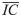
Competition localization increases with growth rate or the distances between colonies, and decreases with the resource diffusion constant.A) Two simulation “maps” with the same founder cell geometry but different growth rates. Circle size is proportional to final biomass of colonies begun with a single founder cell in a spatial environment after resources have been exhausted. The lines designate the Voronoi polygons. The text above each simulation diagram shows ζ on top. On the bottom we show the growth rate (μ1) back-calculated from the scaled model’s ζ when the resource diffusion constant is similar to that of glucose in agar and the simulation area is 2.5cm X 2.5cm. B) A plot of relative biomass (biomass of a focal colony divided by the summed biomass of all colonies) versus relative polygon area (polygon area of a focal colony divided by the total simulation area) for the two simulations shown in A. Each point represents a different colony. The lines are linear least-squares fits, and the slope of each line is our measurement of competition localization. C) Competition localization versus ζ for two different founder densities. Each point is the mean competition localization for a given growth rate and founder density. Vertical error bars are standard deviation of 10 replicates each with different founder locations. Horizontal error bars are standard deviation of ζ due to different mean nearest-neighbor distances across maps (IC¯, see Materials and Methods).